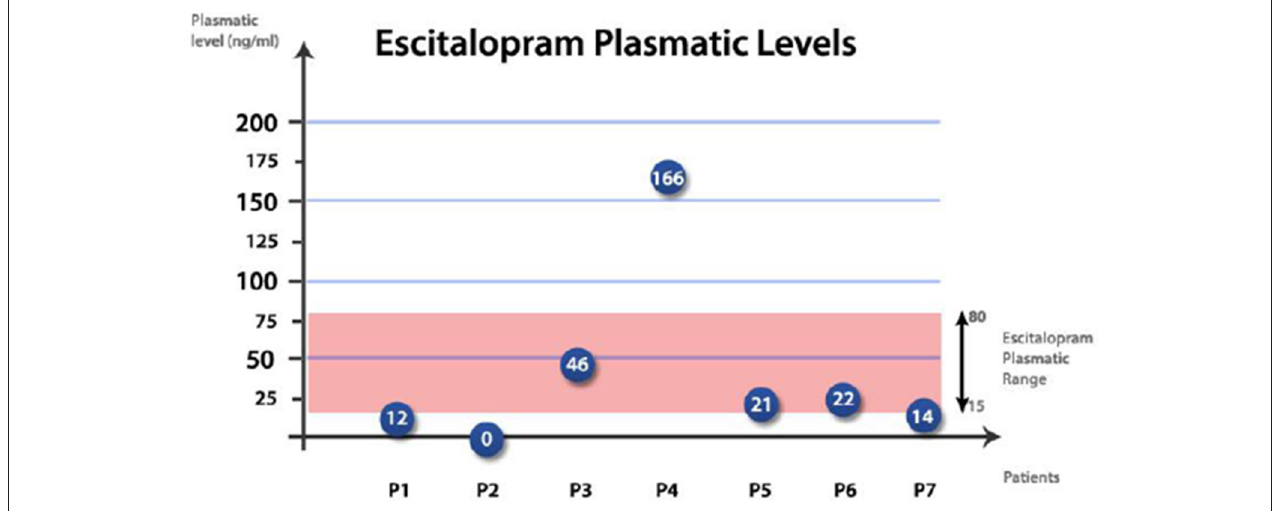
FIGURE 1 | Plasma levels of escitalopram in our seven